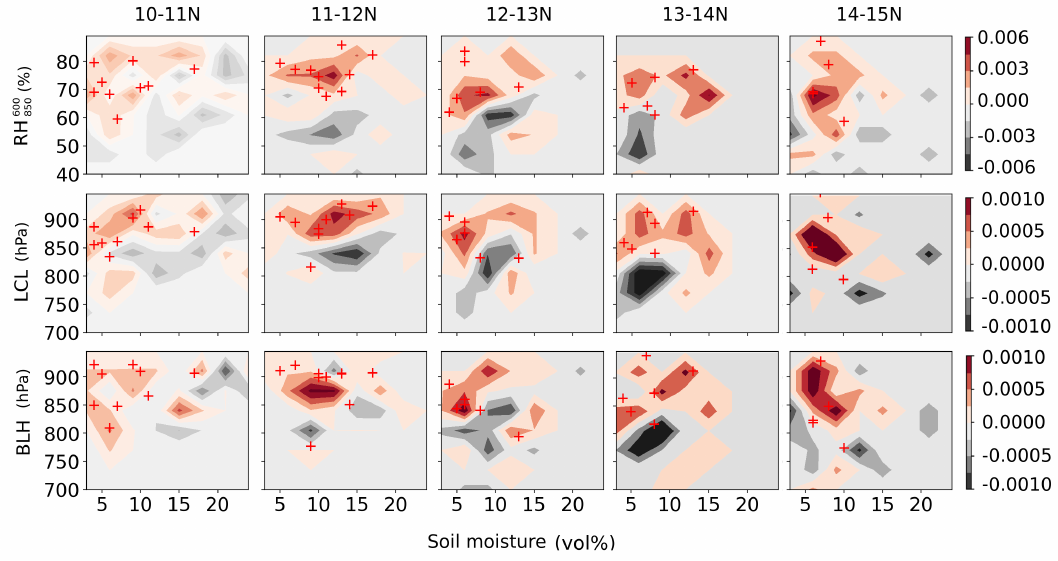
Figure A5. Same as Figure 6a–c, but for every African domain separately. Note, that pressure levels on the y -axis of LCL and BLH plots have a reverse